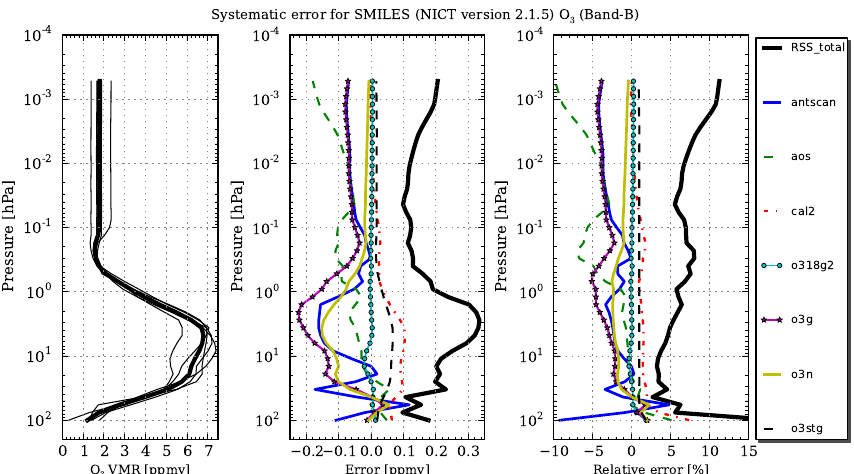
Fig. 3. Estimated systematic errors for an O 3 (Band-B) profile from the NICT Level-2 v2.1.5. Left panel shows the reference O 3 profiles used for the error estimation. Center and right panels show the estimated error in O 3 retrieval with absolute and relative values, respectively. In these panels, the thick black line represents the total systematic error calculated with the root-sum-square of the individual error sources. Other notations are the error from the uncertainty of antscan: the antenna FOV drift; aos: the AOS spectrometer; cal2: nonlinearity gain correction; o318g2: the pressure broadening parameter γ of asym-18-O 3 at 625.563GHz; o3g: the pressure broadening parameter γ of O 3 ; o3n: the temperature dependence of γ of O 3 ; and o3stg: the line intensity of O 3 . Also see Table 3 for the assumed uncertainties on these error sources. The errors from the uncertainties of the image side-band, dry continuum, and other spectroscopic parameters are not shown in here because of their relatively small impacts.